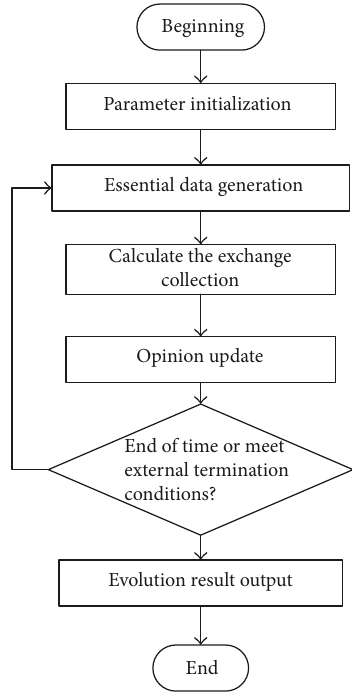
Figure 3: HI model algorithm